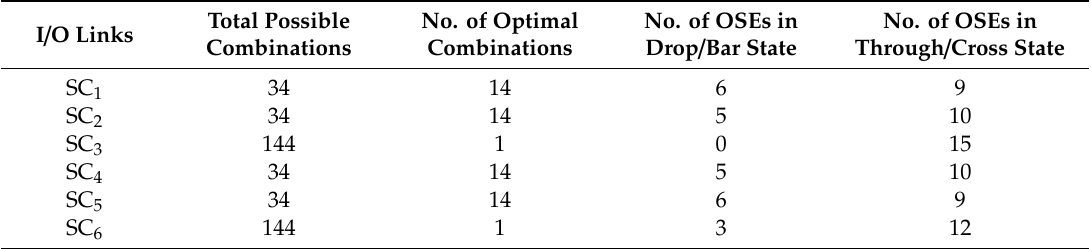
Table 6. Analysis of optimal switching combinations in un-optimized